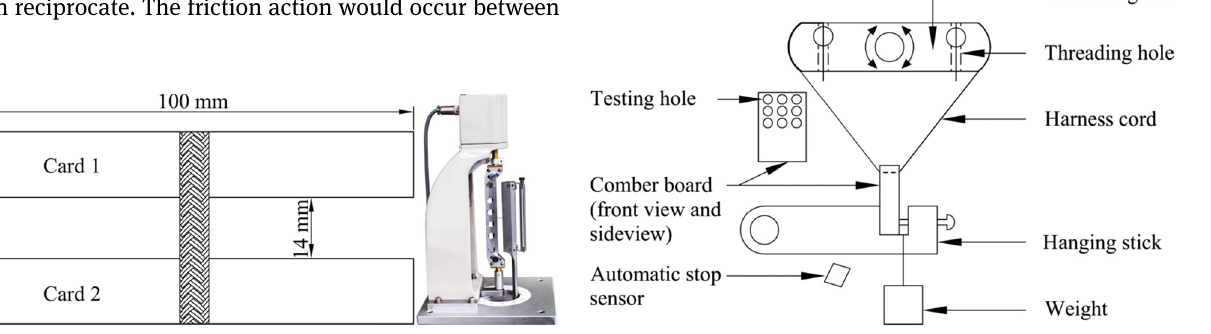
Figure 4: Specimen and determination of bending properties. Figure 5: Schematic diagram of wearability test for harness